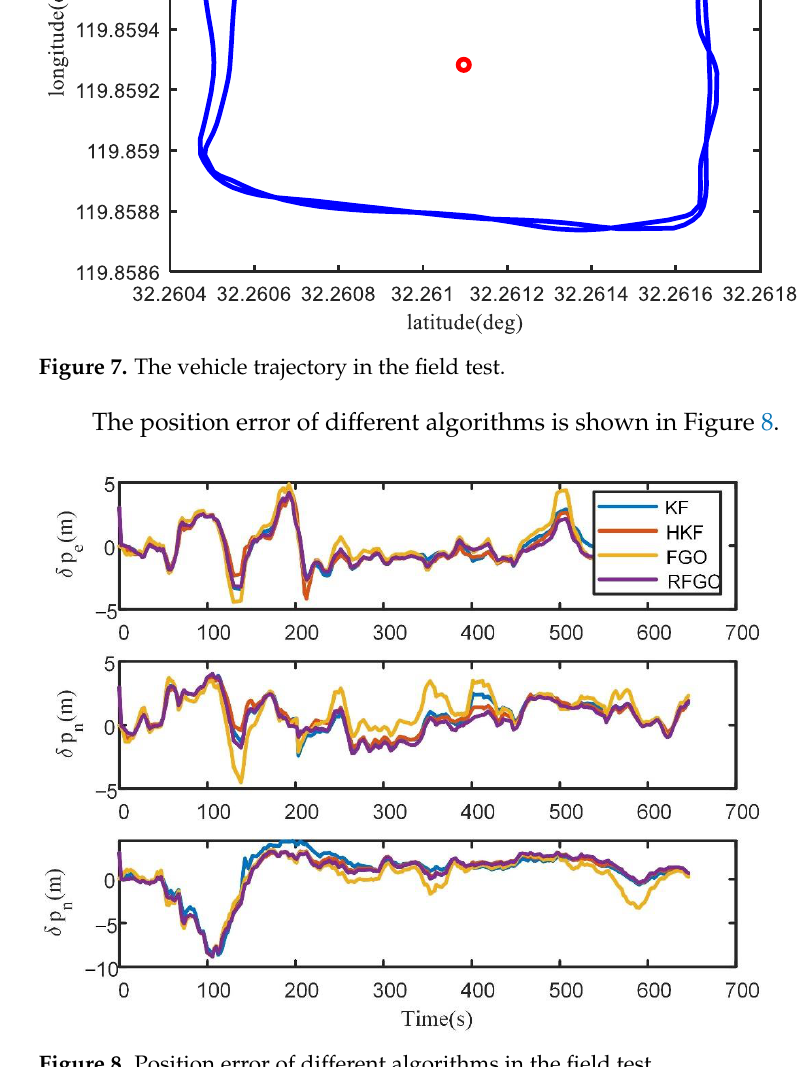
Figure 8. Position error of different algorithms in the field test.